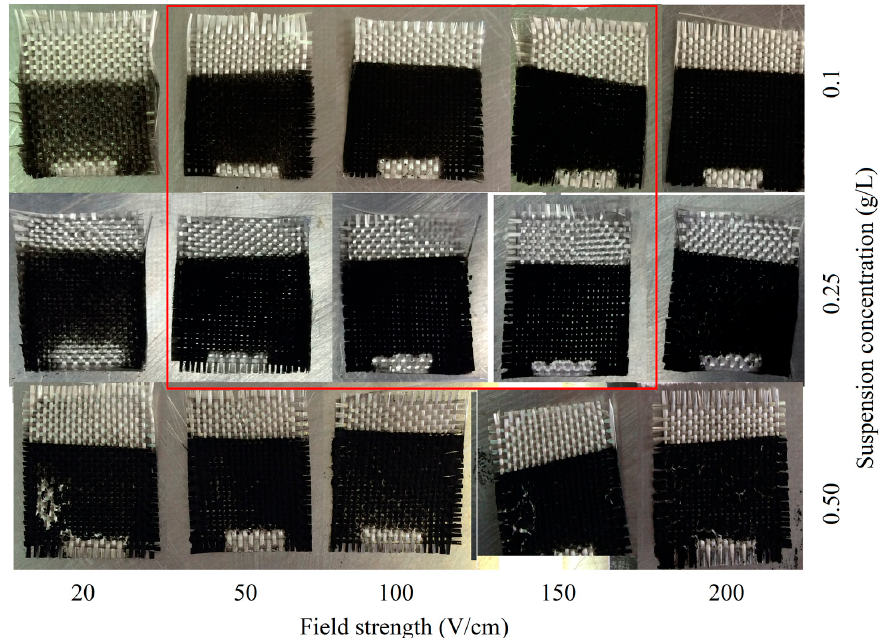
Figure 6. Effect of different field strengths and CNT concentrations in EPD of CNTs on the surface of GTs.